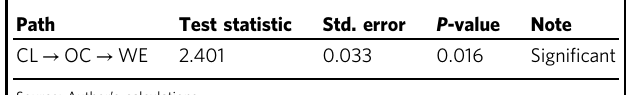
Table 6 The results of the mediation in fl uence test (Sobel